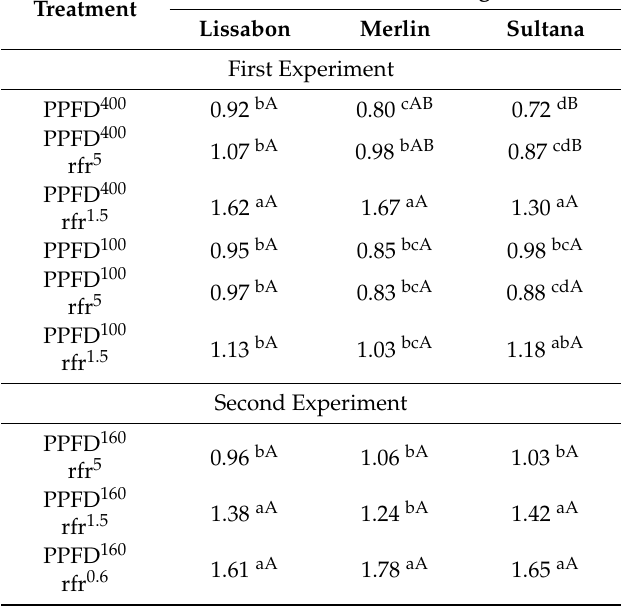
Table 5. The least square means of rachis length for the three cultivars in the first (top) and second (bottom) experiment. For each experiment, lower case letters indicate significant differences between treatments for each cultivar, and upper case letters indicate significant differences between cultivars for each treatment ( p < 0.05).